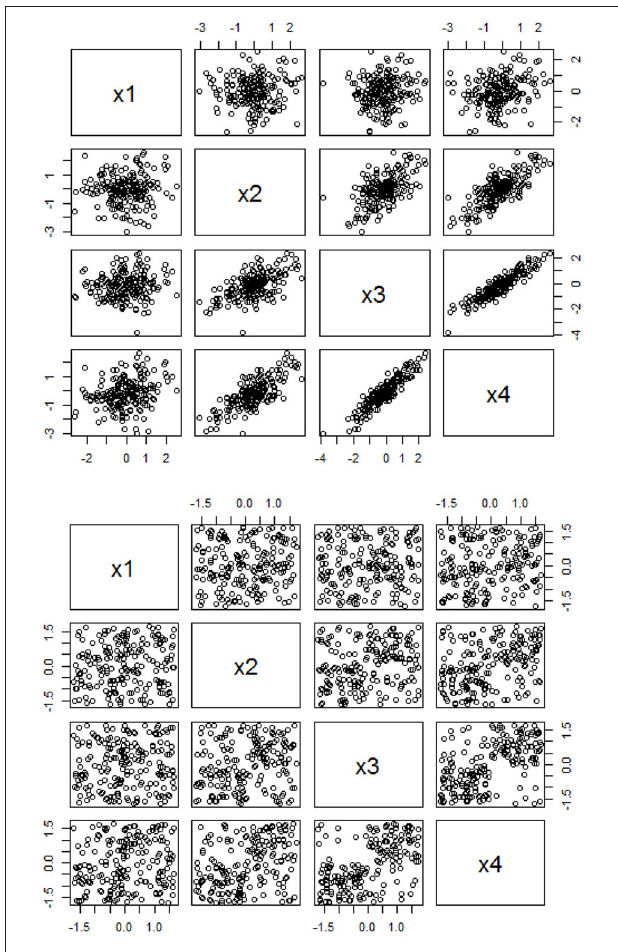
FIGURE 1 | Scatterplots based on the linear-based and PS-based data. The top panel is based on the linear-based correlations among four variables with a  correlation matrix of